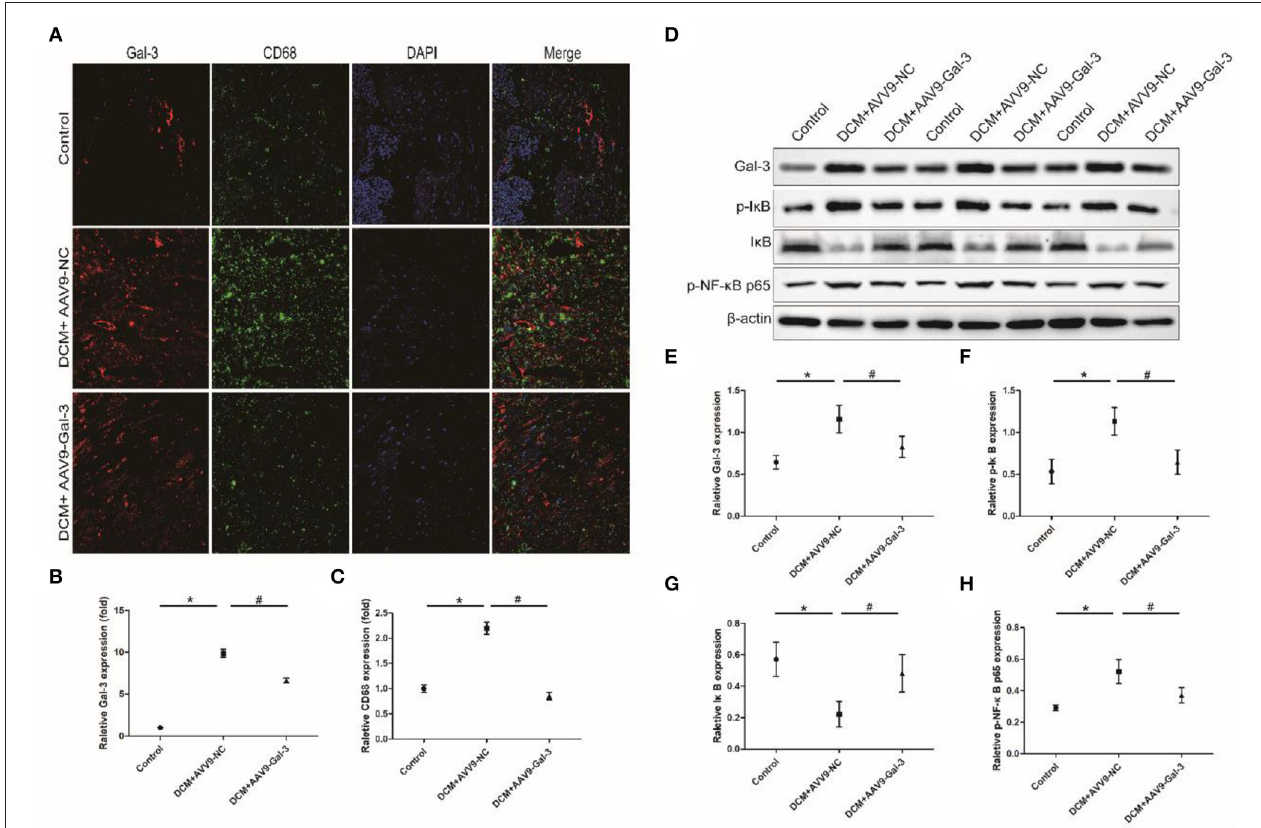
FIGURE 6 | Gal-3 inhibition reduced diabetes-induced macrophage infiltration and NF- κ B p65 activation. (A–C) Immunofluorescence staining of CD68 and Gal-3 in heart tissue at 16 weeks after STZ injection. (D–H) Western bloting analysis of Gal-3, p-I κ B, I κ B and p- NF- κ B p65. Data are shown as mean ± SD. n = 3, * P < 0.05 vs. Control; # P < 0.05 vs. DCM +